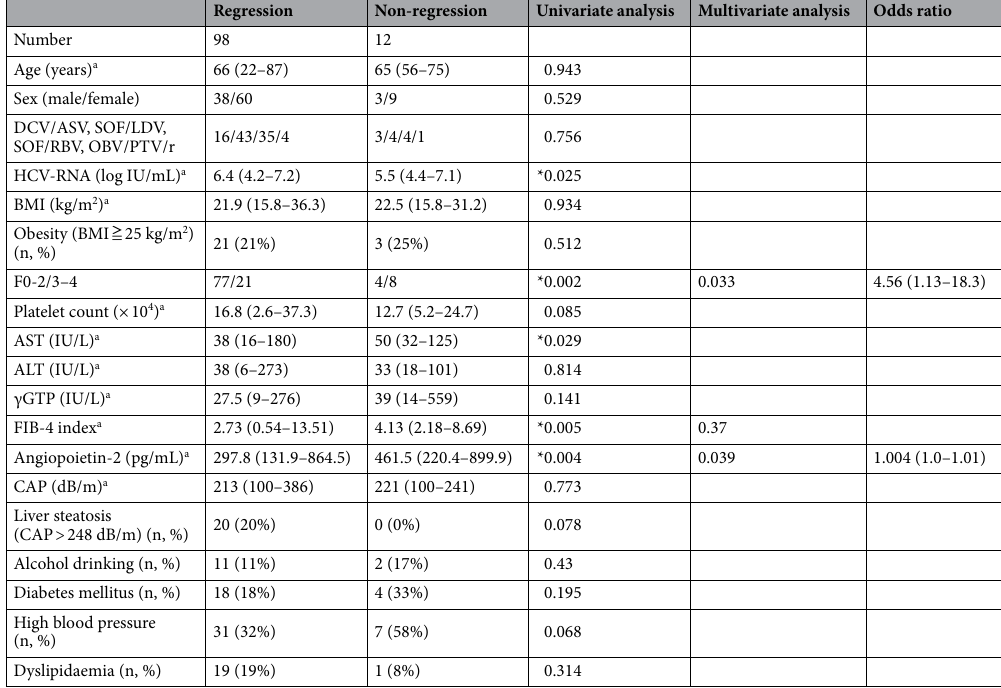
Table 2. Factors associated with non-regression of liver fibrosis stage based on LSM between baseline and SVR96 in HCV-infected patients treated with DAAs. HCV hepatitis C virus, BMI body mass index, AST aspartate aminotransferase, ALT alanine aminotransferase, γGTP γ-glutamyl transpeptidase, FIB-4 fibrosis 4, CAP Controlled Attenuation Parameter. a Data are shown as median (range) values. *Statistically significant difference, P <